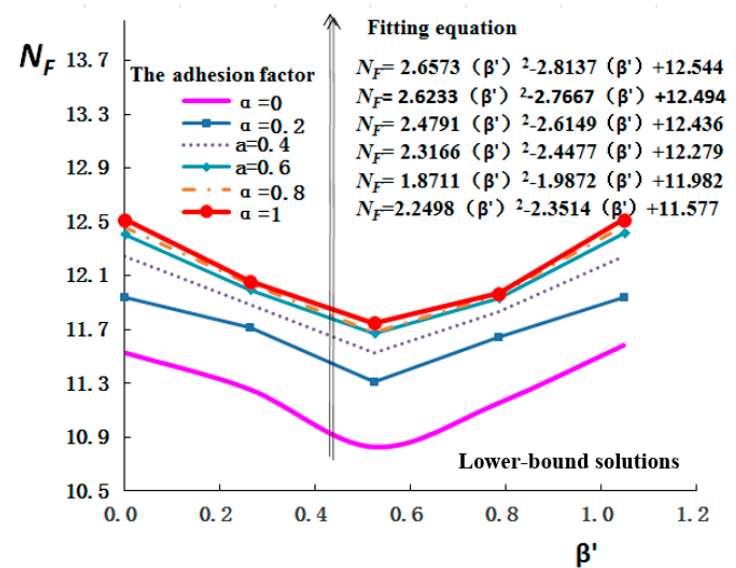
Figure 9. Relationship between the normalized ultimate lateral capacity ( N F ) of the three-wing pile and the direction of the lateral load ( β ’) when the wing-to-diameter ratio D e / B w = 2.5. ( Top ) upper- bound and ( Bottom ) lower-bound solutions from limit analysis with different pile–soil interaction coefficients (adhesion factors).